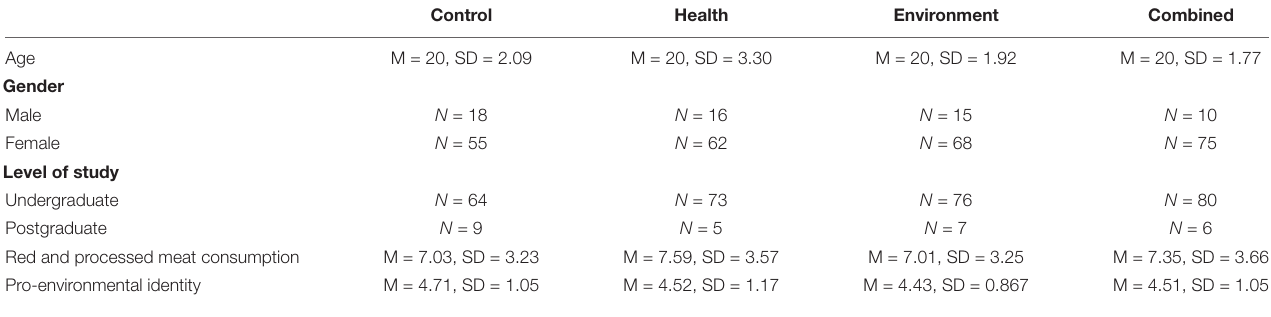
TABLE 1 | Participant demographics and variables of interest by condition at